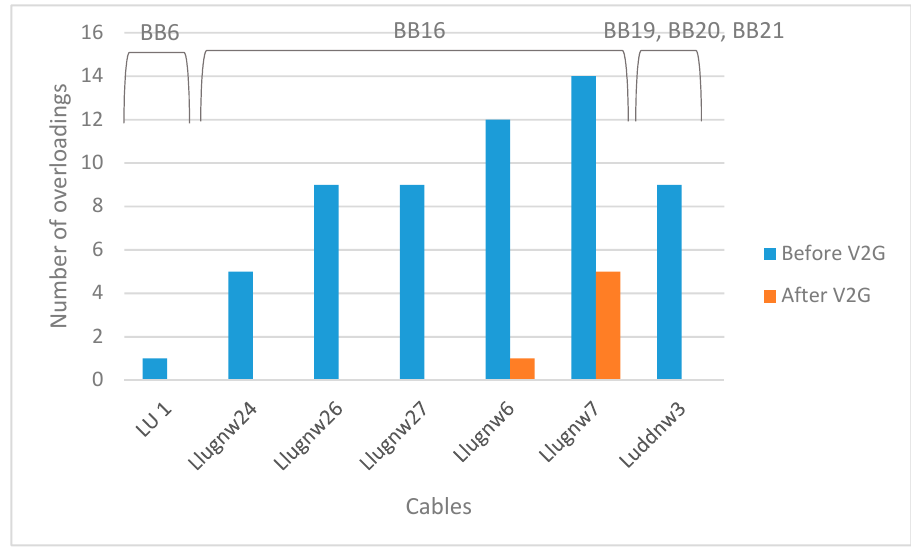
Figure 7. Cables overloadings over the selected critical